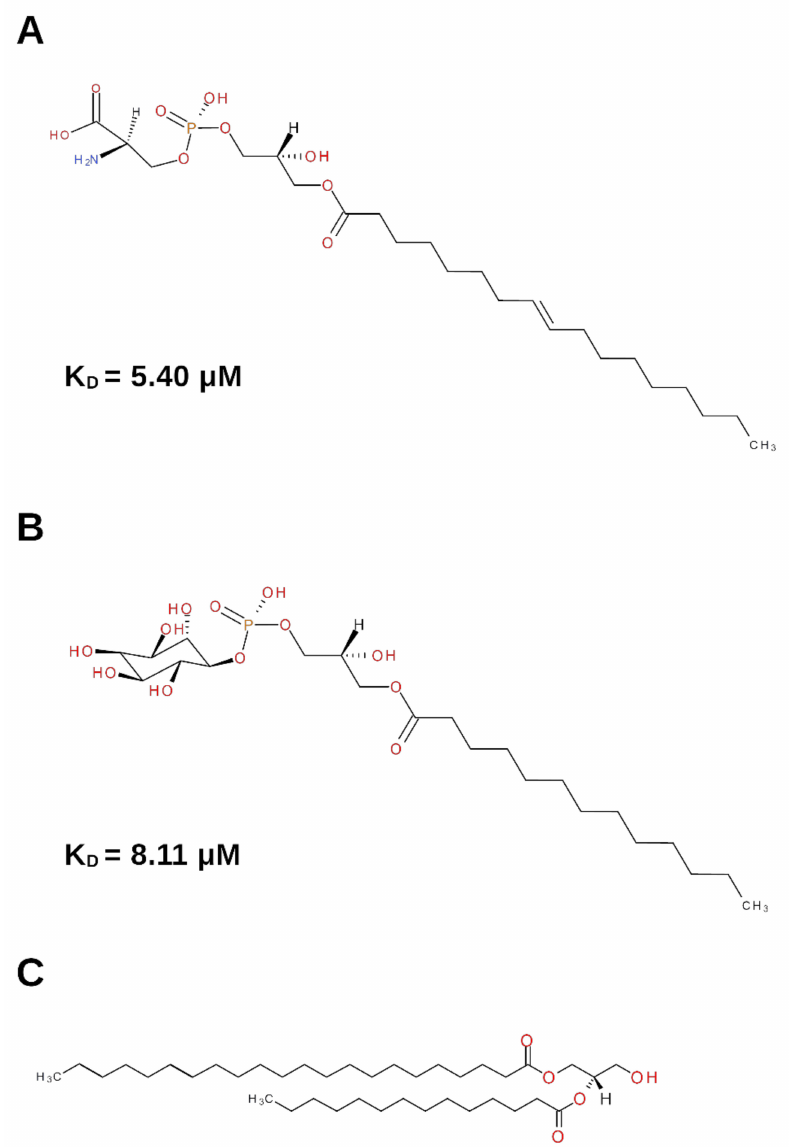
Figure 1. Schematic representation of the lysophospholipids involved in NGF binding. ( A ) Lysophos- phatidylserine (Lyso-PS). ( B ) Lysophosphatidylinositol (Lyso-PI). ( C ) Diacylglycerol (DG). The K D value of the binding of the lysophospholipids to NGF, when available, is